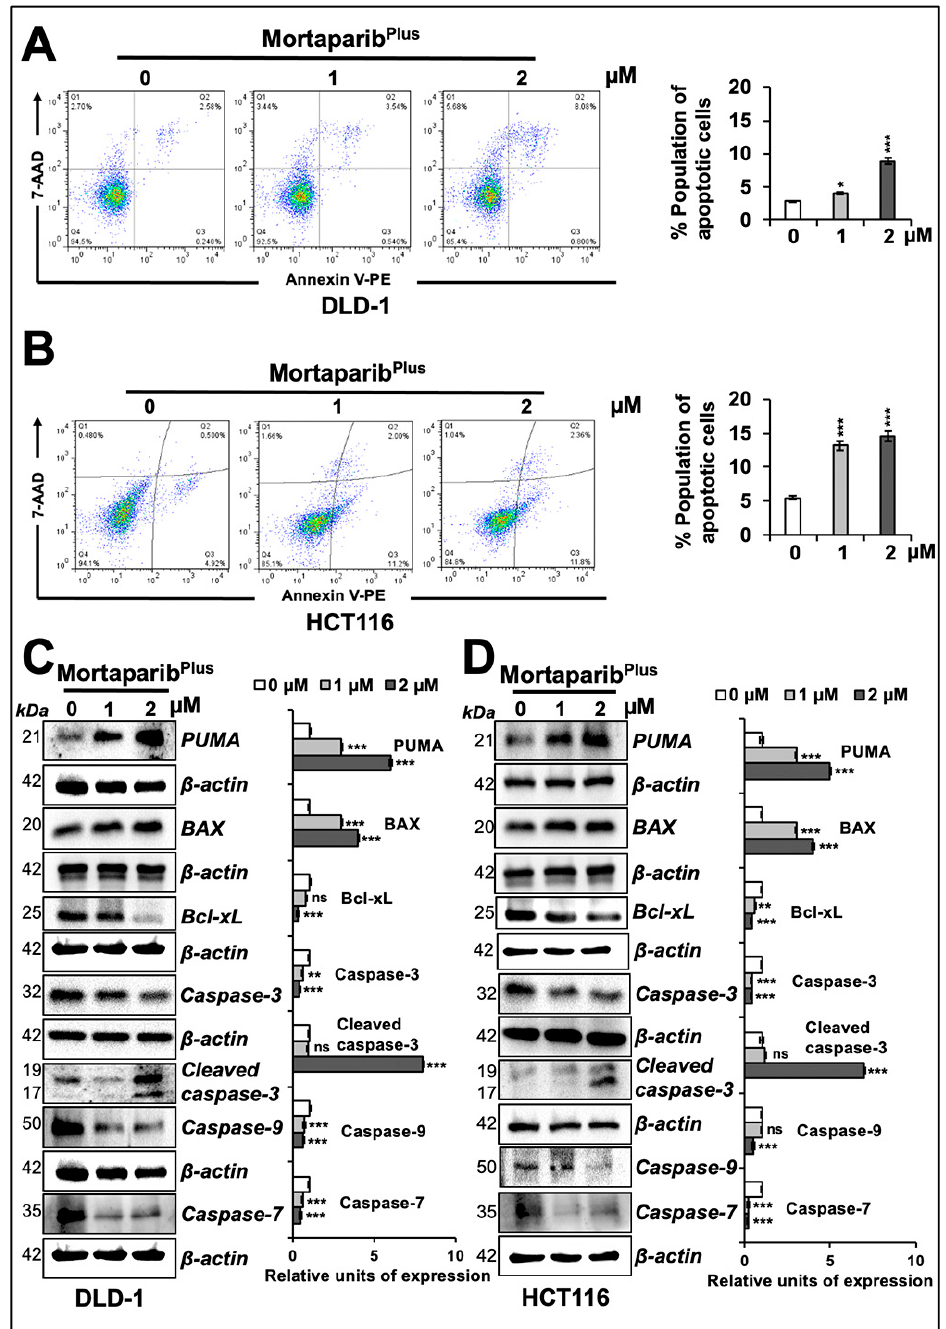
Figure 4. Mortaparib Plus induced apoptosis in colorectal cancer cells. Flow cytometric analyses for control and 24 h Mortaprib Plus -treated cells showed an increase in the percentage of apoptotic cell populations in a dose-dependent manner ( A , B ). Western-blot analyses of control and 24 h Mortaparib Plus -treated colorectal cancer cells showed different changes in the levels of key proteins favouring the initiation of apoptosis as a tumour suppression fate ( C , D ). Note that the loading control ( β -actin) for PUMA and Caspase-9, and Bcl-xL and Caspase-7 in panel C are the same. Similarly, β -actin for Bcl-xL and Caspase-7 & -9 in panel D is the same. β -actin for Caspase-3 in panel D is also the same as in Figure 3B. The quantified data represents mean ± SD obtained from at least three independent biological replicates; p -values were calculated using unpaired Student’s t -test. * < 0.05, ** < 0.01, and *** < 0.001 represent significant, very significant and very very significant,